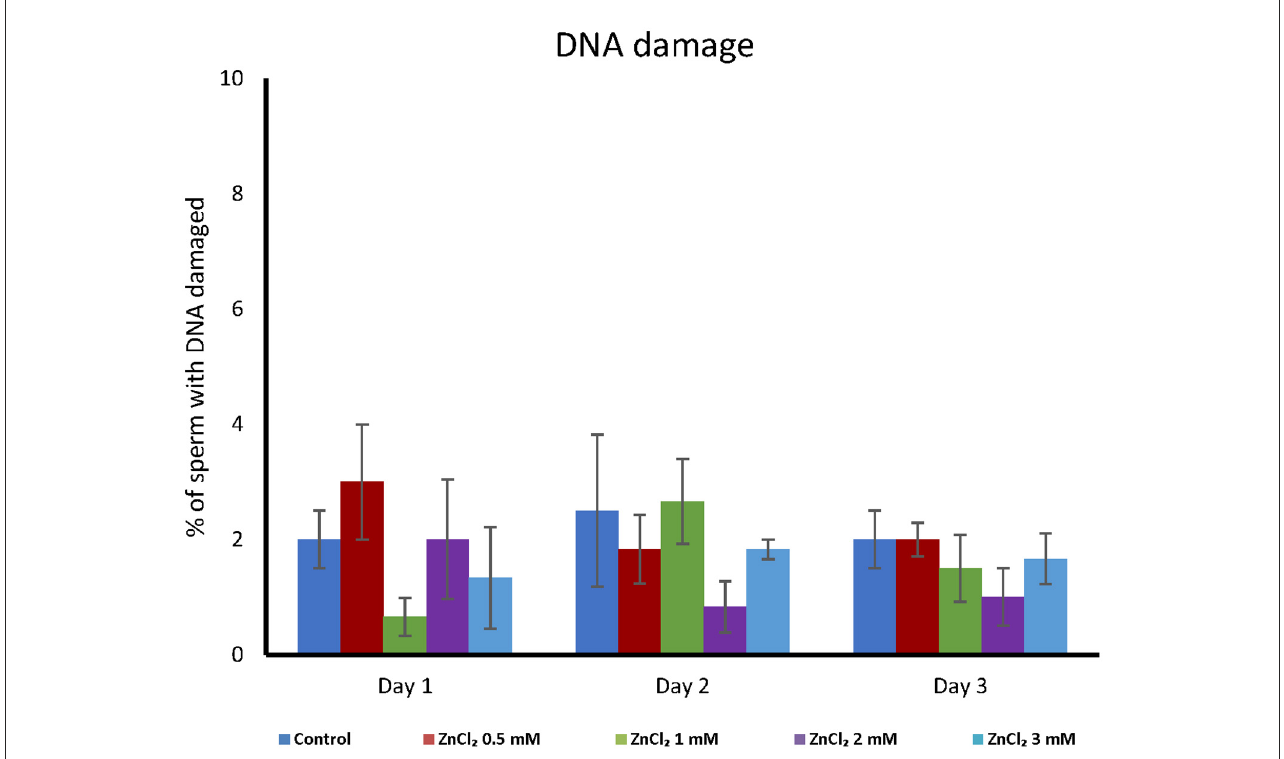
FIGURE4 DNA integrity analyses. Seminal doses were supplemented with the indicated concentrations of ZnCl 2 and analyzed during 1, 2, and 3-days. DNA integrity was measured together with mitochondrial status. The integrity of chromatin did not show differences between treatments or day of evaluation ( n = 8).